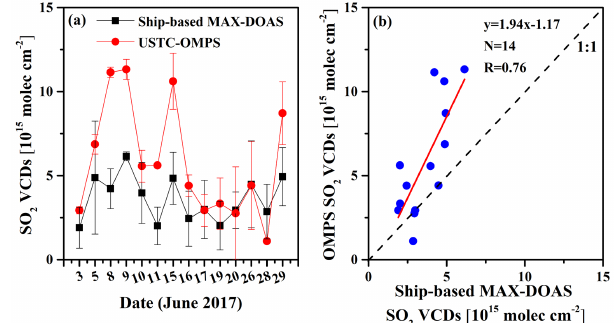
Figure 6. Time series (a) and correlation analysis (b) of the tropo- spheric NO 2 VCDs measured by ship-based MAX-DOAS and the OMI satellite during this campaign.